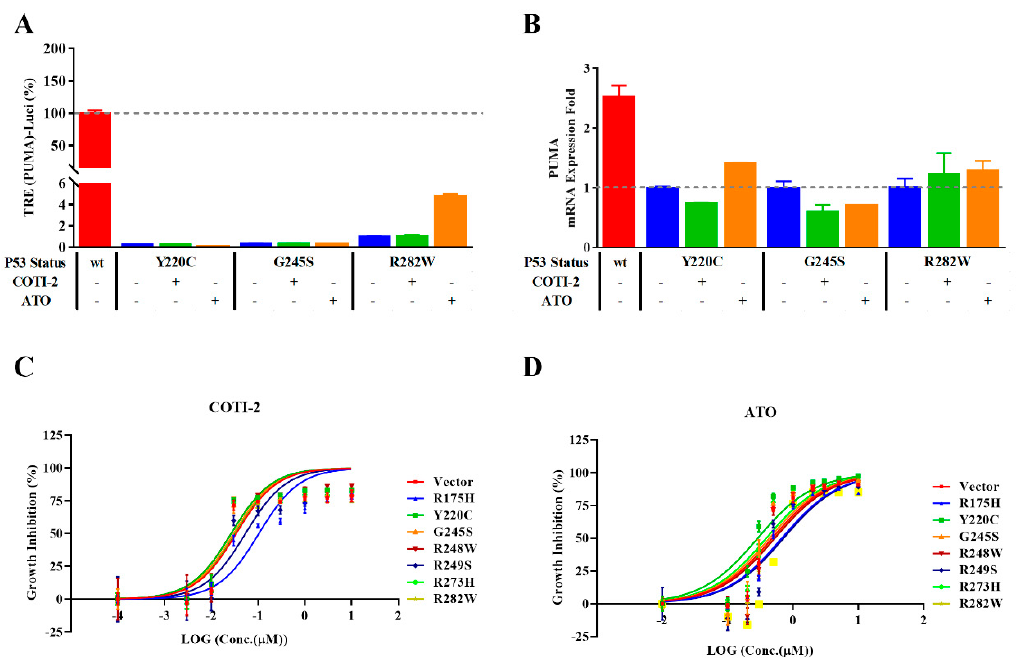
Figure 5. An improved reporter gene system was applied for evaluating mutP53 reactivators. ( A ) Reporter gene assay for measuring TRE activation of PUMA ( n = 3). ( B ) RT − qPCR analysis of PUMA mRNA expression after treatment with P53 activators (0.1 µ M COTI − 2 or 1 µ M ATO) for 24 h. ( C , D ) Cell growth inhibition of different P53 status and negative control after treatment with COTI − 2 at the final concentrations of 0, 0.003, 0.01, 0.03, 0.1, 0.3, 1, 3, and 10 µ M or ATO at the final concen- trations of 0, 0.1, 0.2, 0.3, 0.5, 1, 2, 3, 5, and 10 µ M, respectively ( n = 3). Data are presented as the mean ± S.D. obtained from three separate